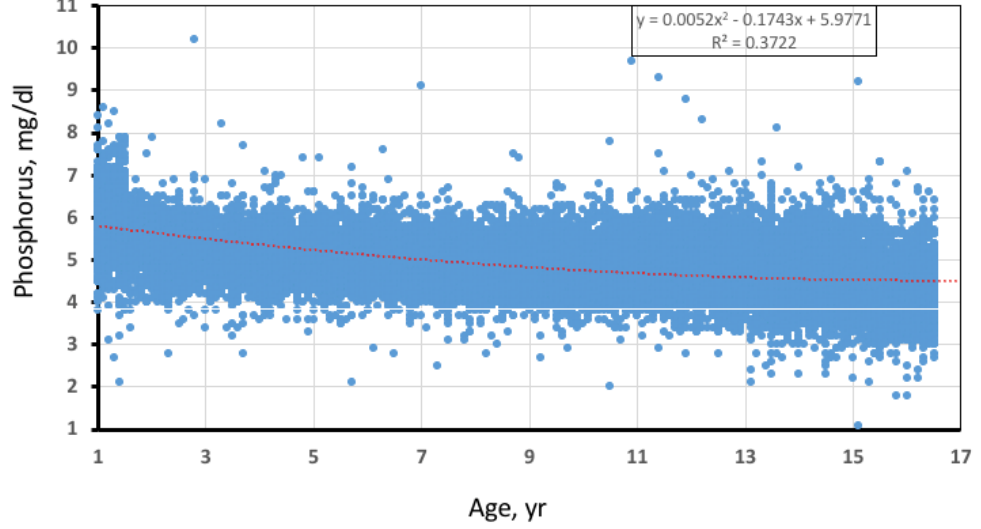
Figure 1. Distribution of serum phosphate results across the pediatric population. Among the 232 patients with hypophosphatemia included in the study, 107 (46.1%) were males and 125 (53.9%) were females. The mean age of the first analysis showing hypophosphatemia was 5.8 years (6.0 years in the retrospective arm and 5.2 years in the prospective arm). The mean age at which each subject showed the lowest serum phosphorus was 6.8 years, with a median of